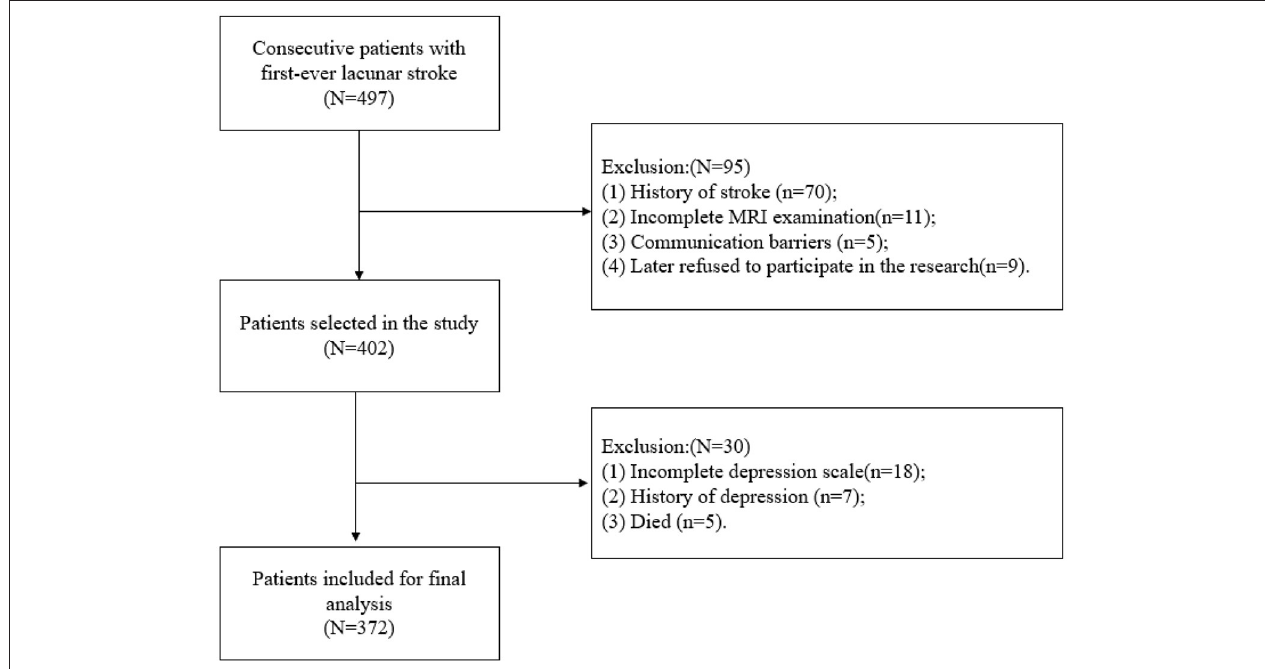
FIGURE 1 | Flow chart of patient